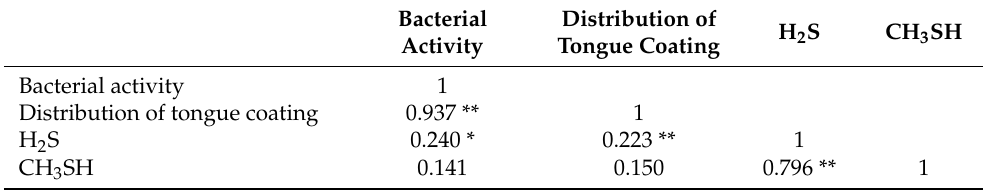
Table 4. Associations of oral malodor, bacterial activity, and the distribution of tongue coating. Bacterial Activity Bacterial activity